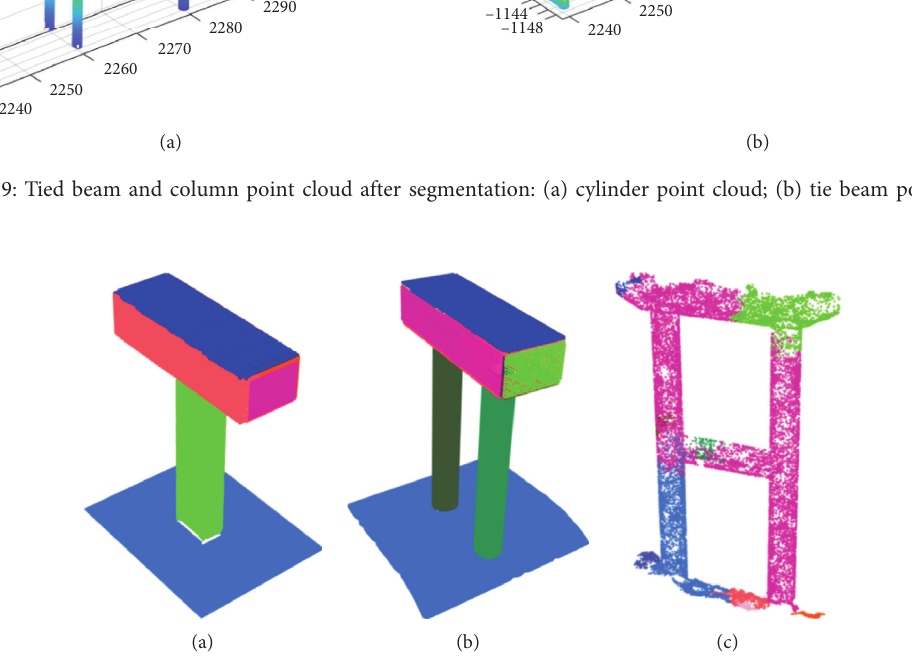
Figure 20: Segmentation test results of RGNC algorithm.